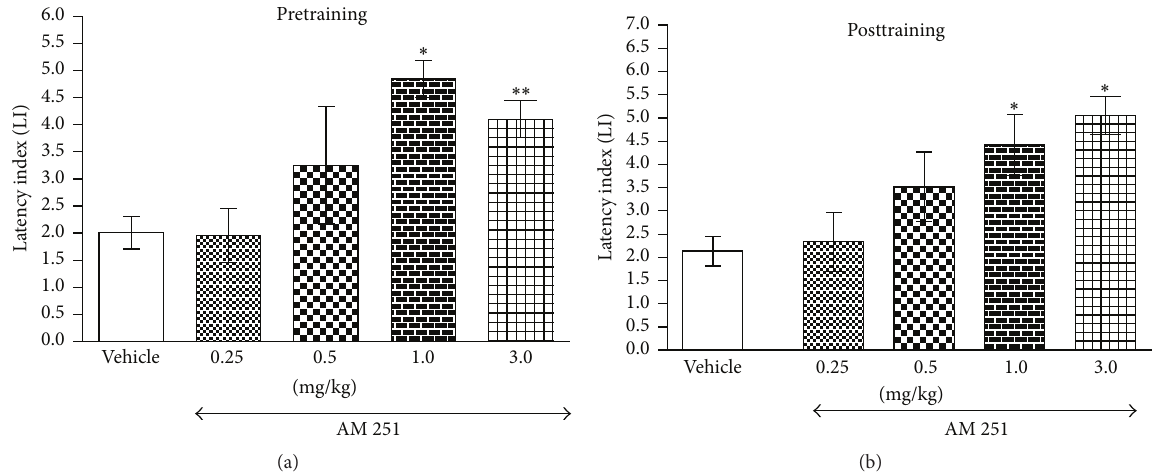
Figure 1: Effects of acute pretraining (a) or posttraining (b) CB1 receptor antagonist AM 251 or saline administration on the latency index (LI) in the PA test in mice. AM 251 (0.25, 0.5, 1.0, and 3.0 mg/kg; ip) or vehicle was administered 30 min before the first trial (a) or immediately after the first trial (b) and the mice were retested 24 h later; 𝑛 = 8 – 12 ; the means ± SEM; ∗ 𝑝 < 0.05 ; ∗∗ 𝑝 < 0.01 versus vehicle-treated control group; Tukey’s test.